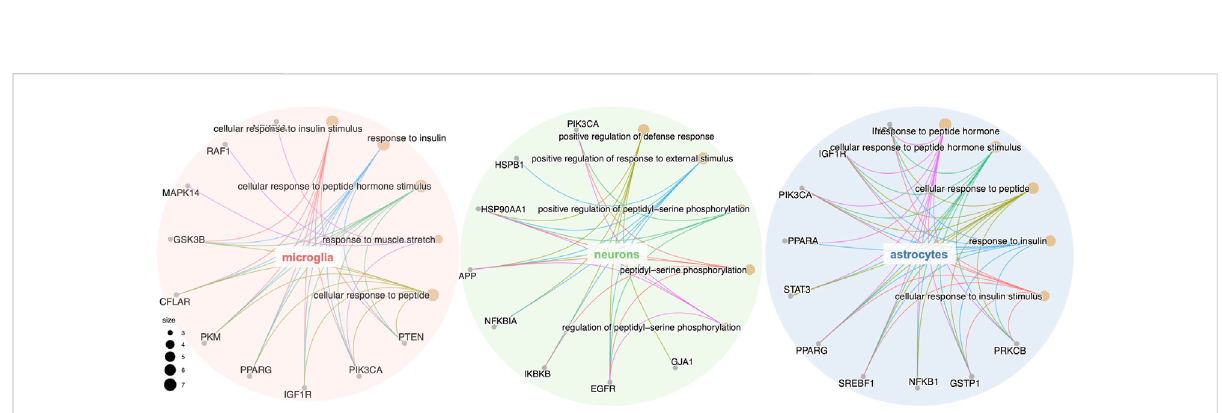
FIGURE 3 GOenrichmentanalysis ofthepotentialGBE targetsfor PDinthreecelltypes.GO enrichmentanalysis ofthepotential GBEtargets inmicroglia, neurons and astrocytes were conducted separately. The top fi ve categories of biological process (BP) for each cell type were shown together with genes enriched in each category. Dot size represents the number of genes enriched in each